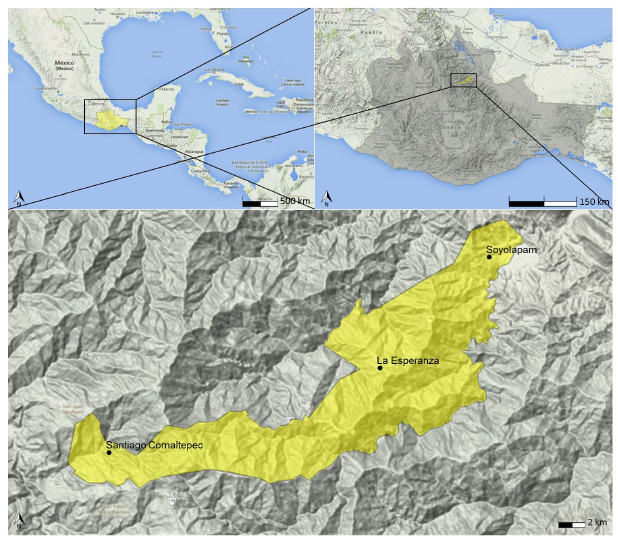
Fig. 2 . Location of the Mexican social-ecological